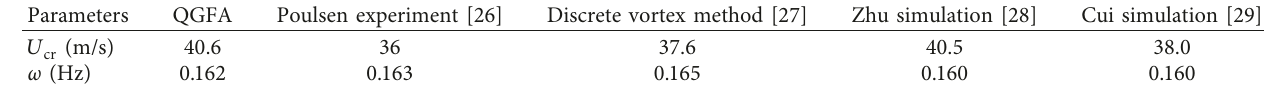
Table 7: Critical wind velocity and critical frequency (Case